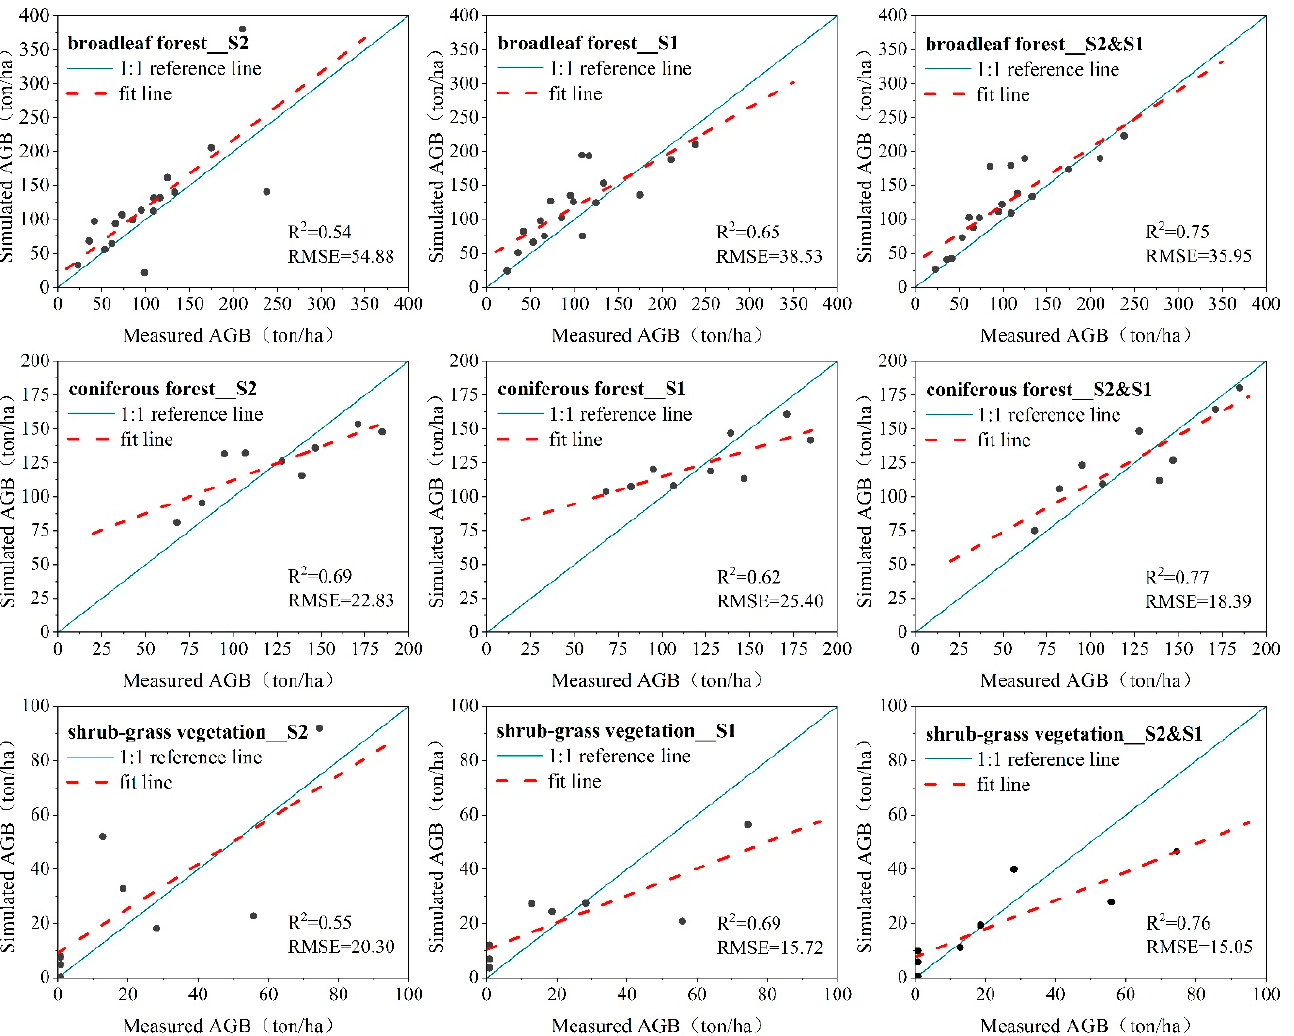
Figure 7. Accuracy assessment of AGB estimation models: S2 refers to Sentinel-2 MSI data, S1 to Sentinel-1 SAR data, and S2&S1 to multi-source data